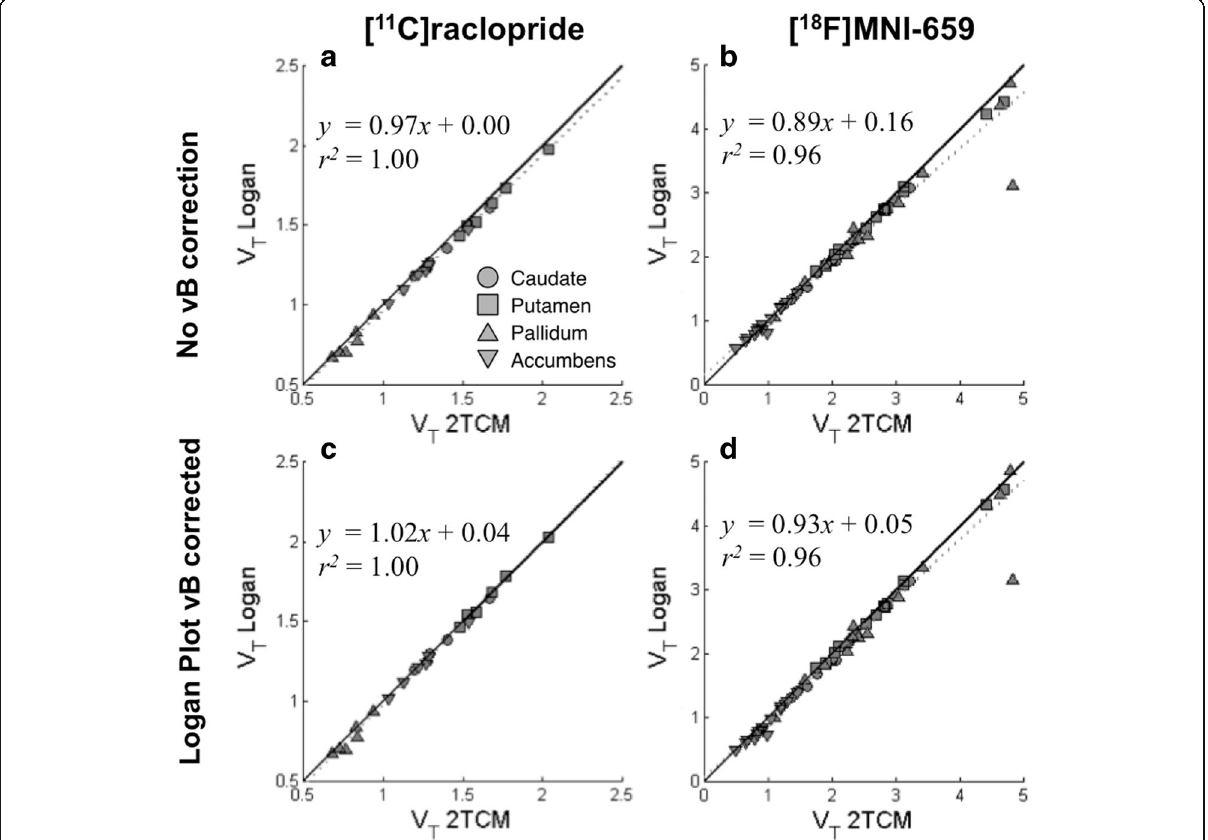
Fig. 3 Distribution volumes ( V T ) obtained with 2TCM plotted against those obtained with Logan plot for all regions except cerebellum where V T from Logan plot are ( a , b ) not corrected, and ( c , d ) corrected for signal from blood vessels, for [ 11 C]raclopride data ( a , c ) and [ 18 F]MNI-659 data ( b , d